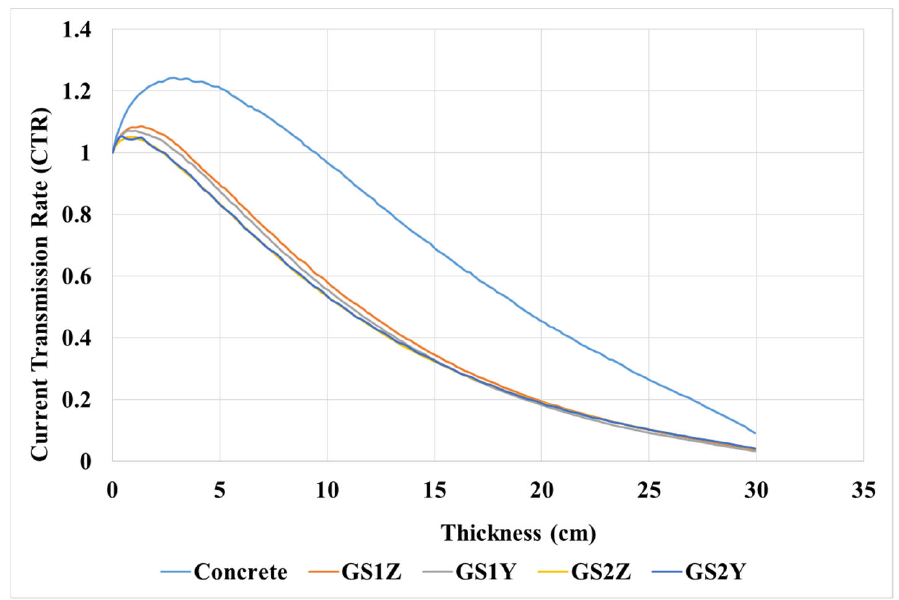
Figure 4. Comparison of CTR obtained from ordinary concrete and GS1.